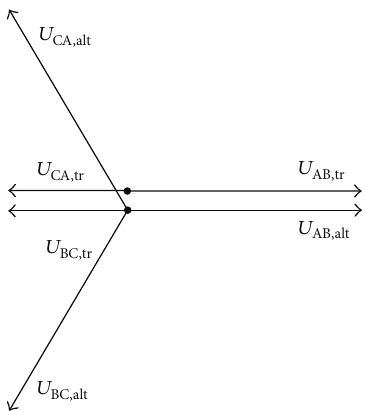
Figure 7: Vector diagram of the three-phase transformer voltages when two phases are